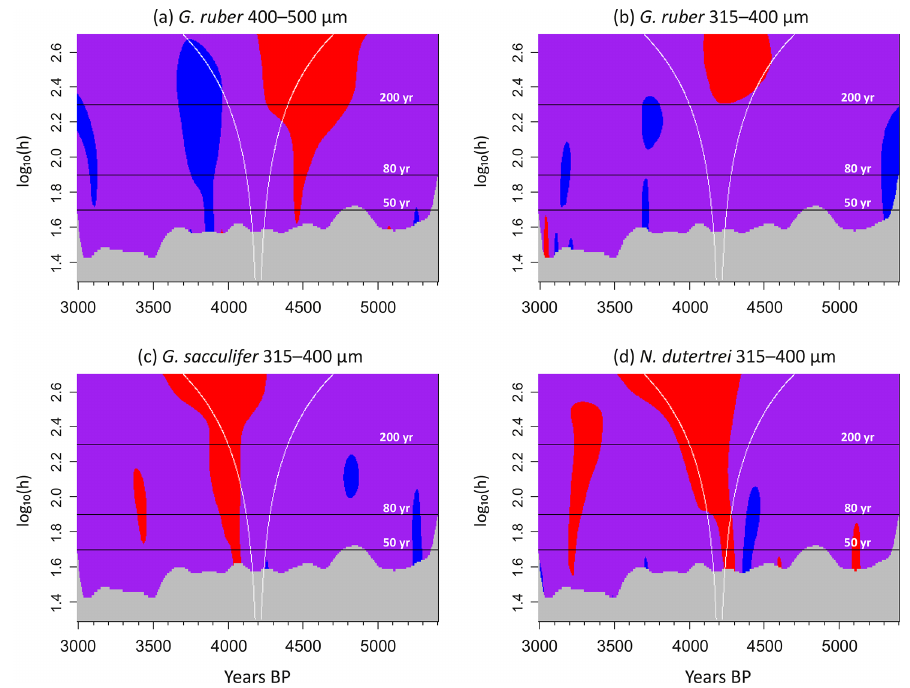
Figure 4. SiZer first derivative analysis (Chaudhuri and Marron, 1999; Sonderegger et al., 2009) applied to δ 18 O of (a) G. ruber 400–500µm, (b) G. ruber 315–400µm, (c) G. sacculifer 315–400µm, and (d) N. dutertrei 315–400µm. The red areas indicate statistically significant increases in δ 18 O, the blue represent decreases, and the purple no significant change. Black horizontal lines are the smoothing bandwidths ( h = 50, 80, and 200 years). The distance between the white lines denotes the change in smoothing bandwidth scaled to the x axis.